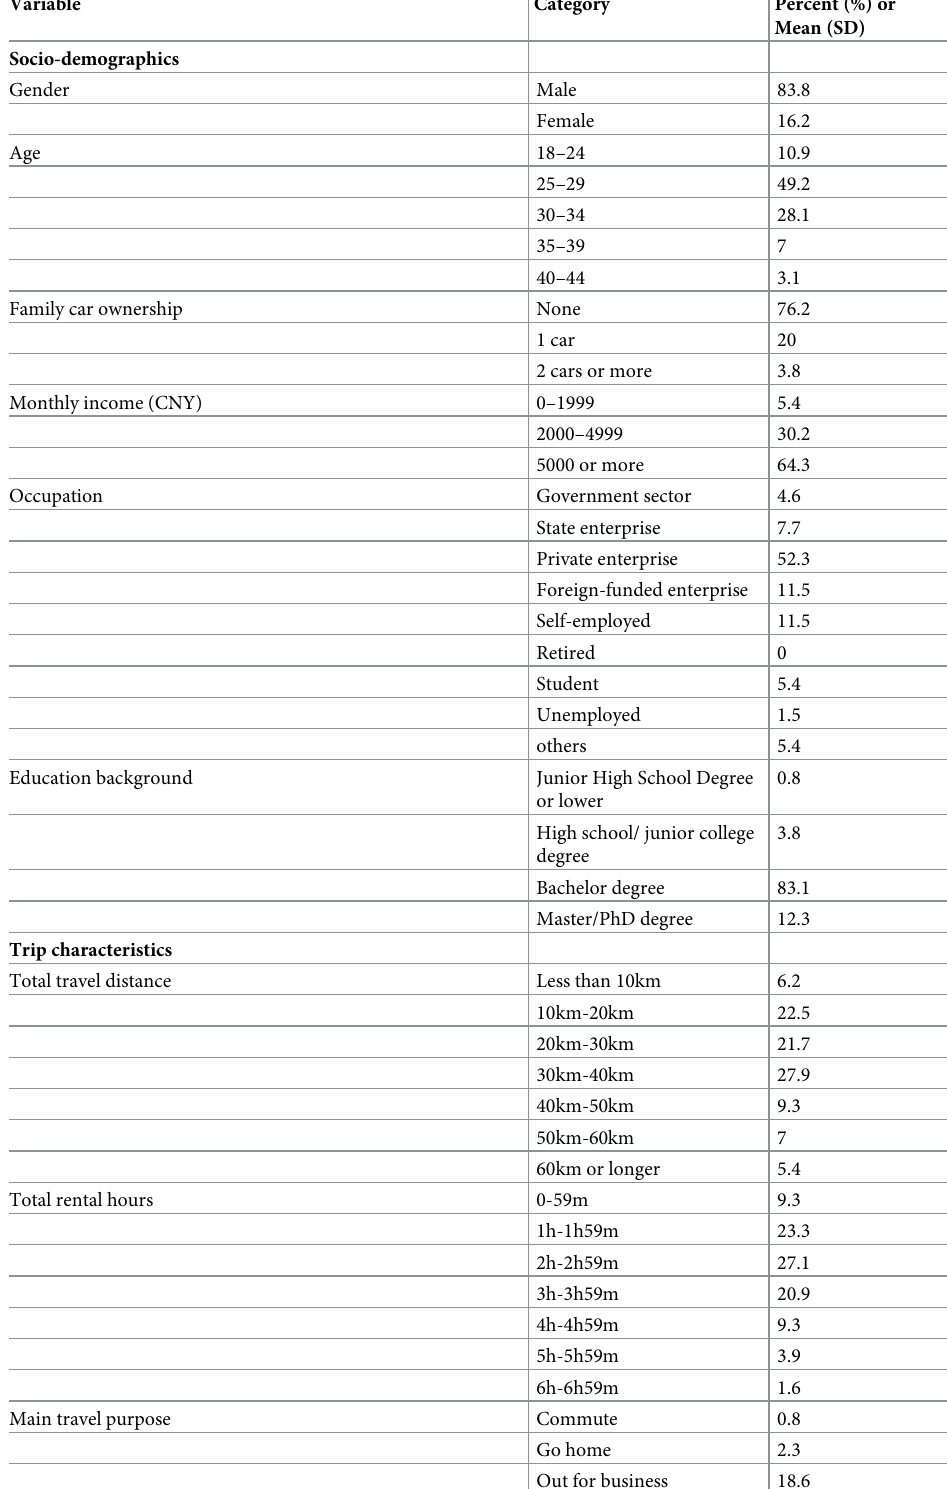
Table 1. Descriptive statistics of